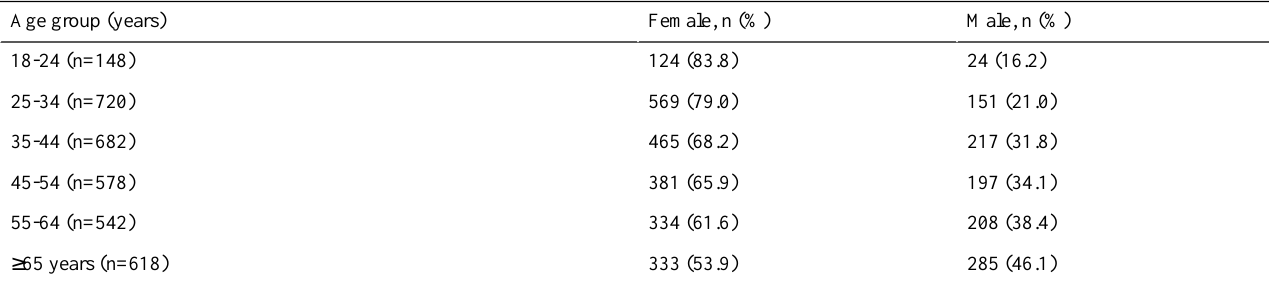
Table 2. Use of the advance care planning patient portal tools by age ( P <.001) and gender